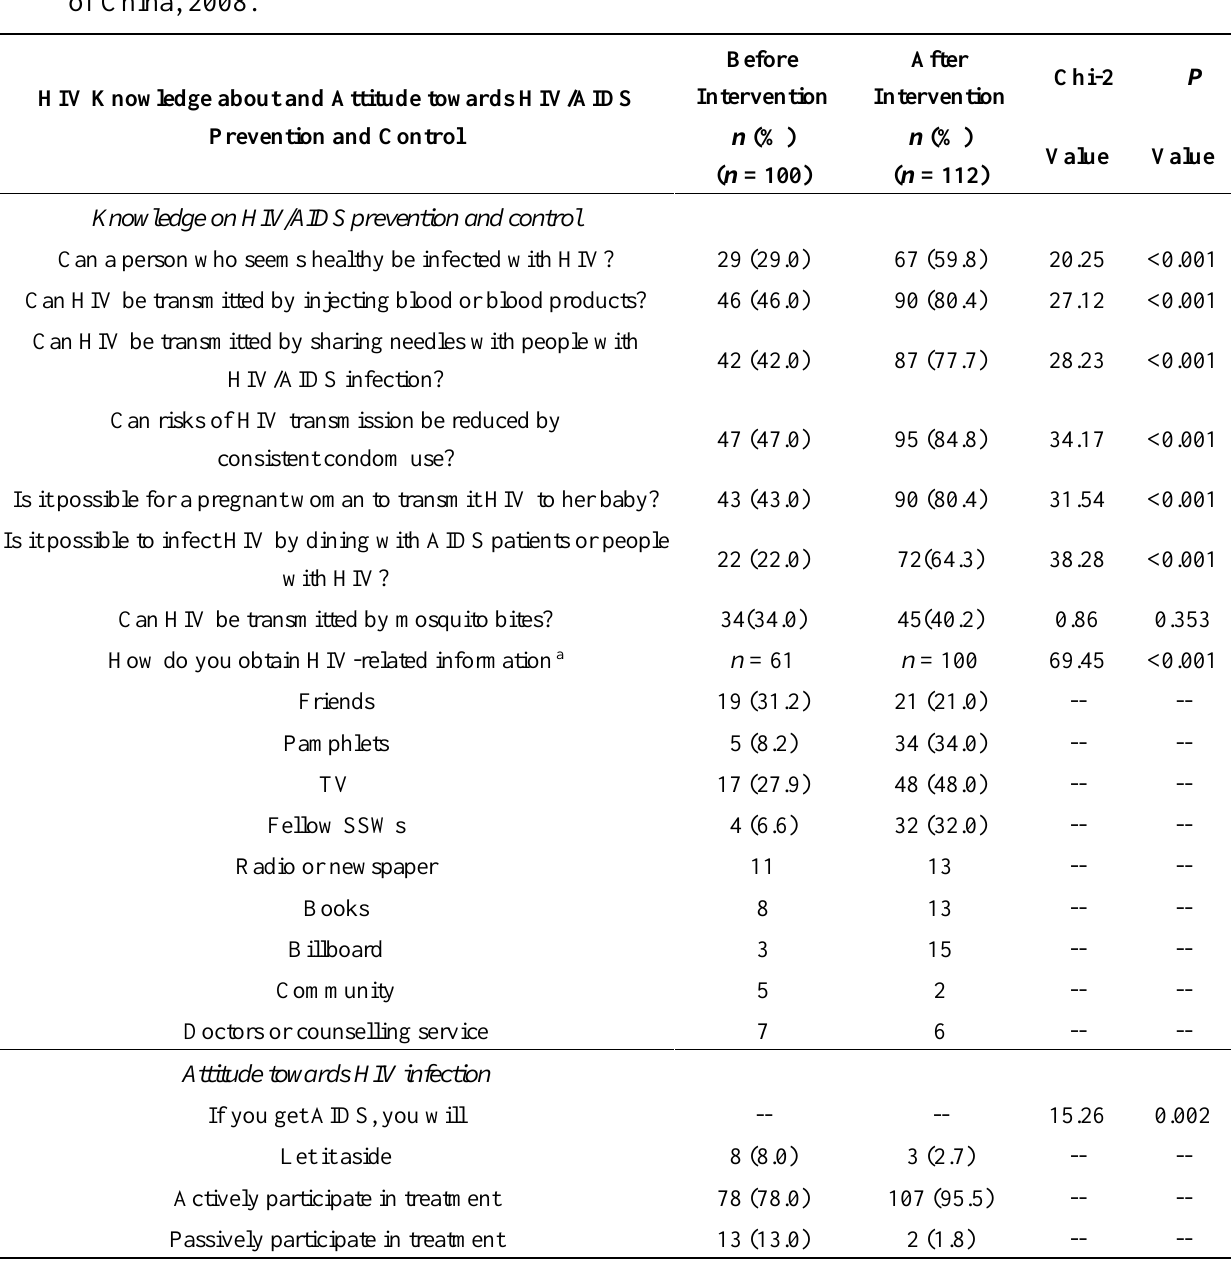
Table 3 . Knowledge about Human Immunodeficiency Virus and attitude towards its prevention in street-based sex workers before and after intervention, Chongqing, Southwest of China,